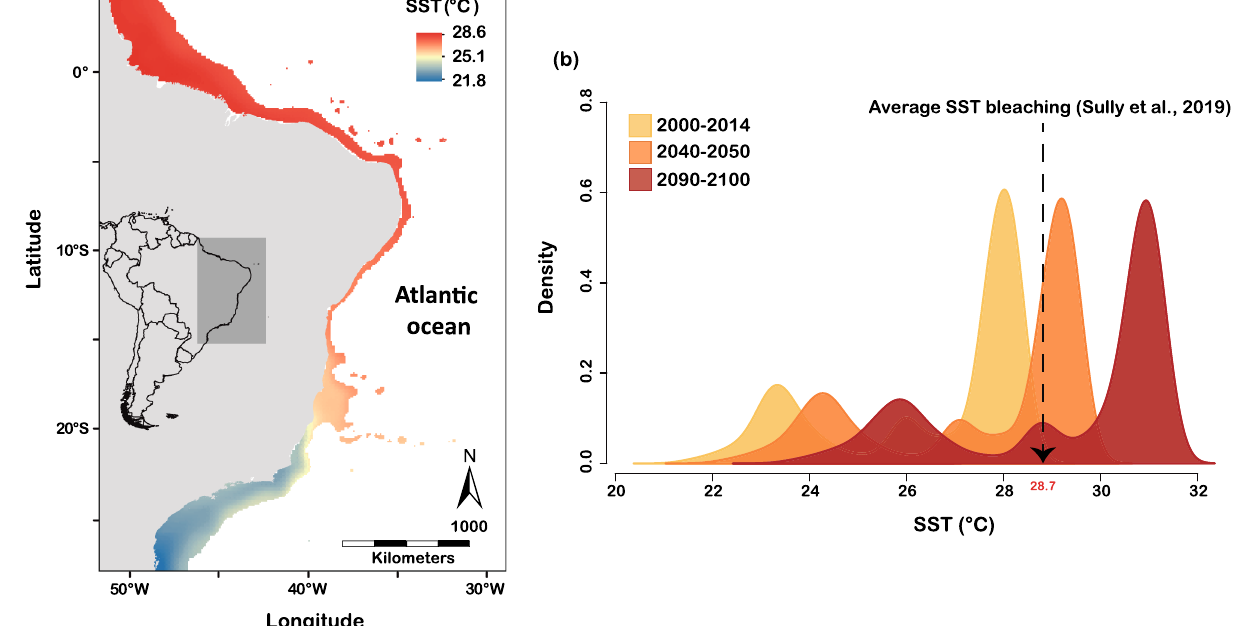
Figure 4. Current and future sea surface temperature (SST) of the Brazilian coast from extracted values of the Bio-ORACLE database. ( a ) Current mean annual SST at the Brazilian coast and ( b ) the density of mean SST extracted along the Brazilian coast for current (2000–2014), and future 2040–2050 and 2090–2100 projected SST under a “business as usual” warming rate (RCP 8.5). The vertical dotted line and arrow points the average threshold SST (28.7 °C) recorded during global coral bleaching events between 2007 and 2017 (Sully et al., 2019). Note that the majority of the regions of mean SST for 2040–2050 and 2090–2100 will exceed mean SST bleaching for the current decade. Density was performed using the Kernel Density Estimation. The Map was created in ArcMap version 10.2 (https:// deskt op. arcgis. com/ en/ arcmap/) and the density graph was plotted using the package “yarrr” 49 in R software 50